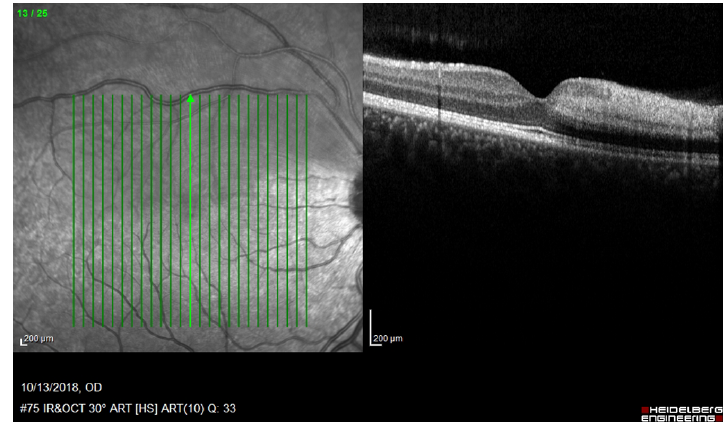
Figure 4: Vertical macular optical coherence tomography of the right eye; thickening and hyperreflectivity of the inner superior macula is a consequence of ischemia caused by superior hemi-central retinal artery